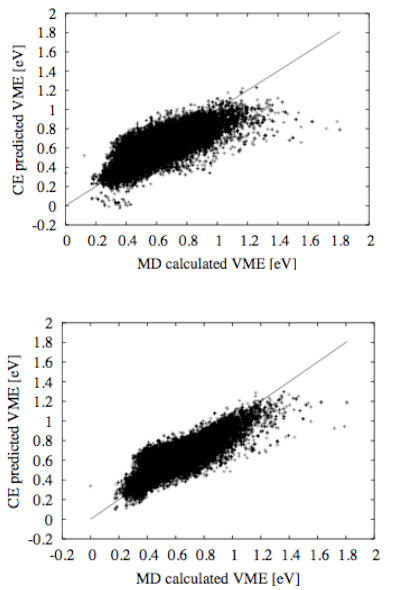
the FeCuVac1nn with pairs interactions (up) and with triplets interactions (down). The average errors are respectively 15.72% and